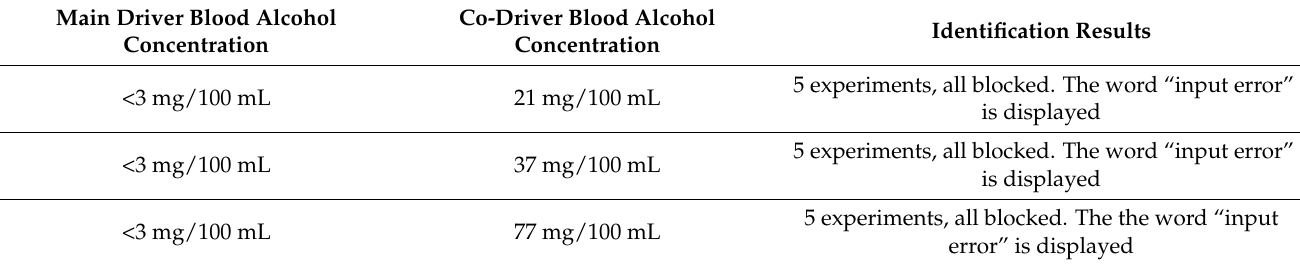
Table 4. Judgment results of driver not drinking but co-driver drinking.